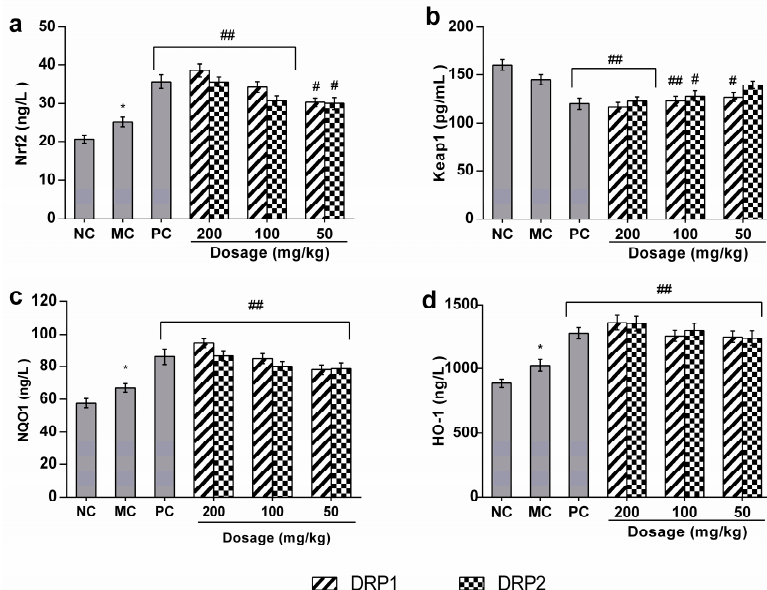
Figure 8. Effects of DRP1 and DRP2 on liver Nrf2, Keap1, NQO1 and HO-1 levels. ( a ), Nrf2 ( b ), Keap1 ( c ), NQO1 ( d ), HO-1. The values presented are the mean ± S.E.M. ( n = 10 in each group). * p < 0.05 compared with the NC group; # p < 0.05, ## p < 0.01 compared with the MC groups.